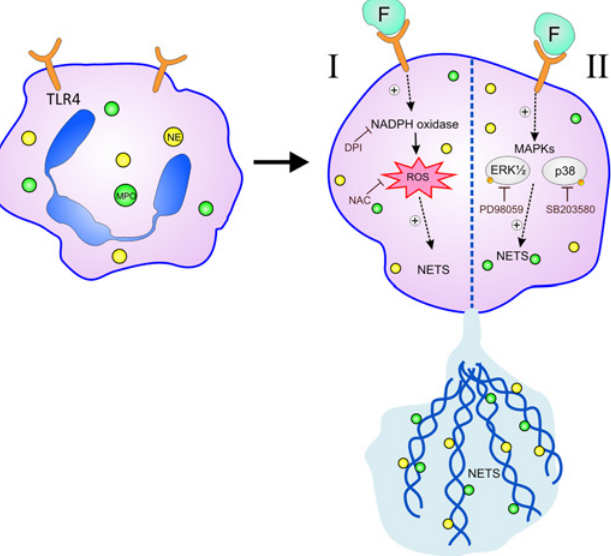
Fig 6. Mechanisms involved in RSV Fusion protein-induced NET formation in human neutrophils. (I) RSV F protein binds to and activates TLR-4, expressed by neutrophils, stimulating ROS production via NADPH Oxidase, which is essential for NET formation. (II) F protein is also able to activate ERK and p38 MAPK to induce NET release. RSV F protein stimulates the production of NETs decorated with the granular proteins NE and